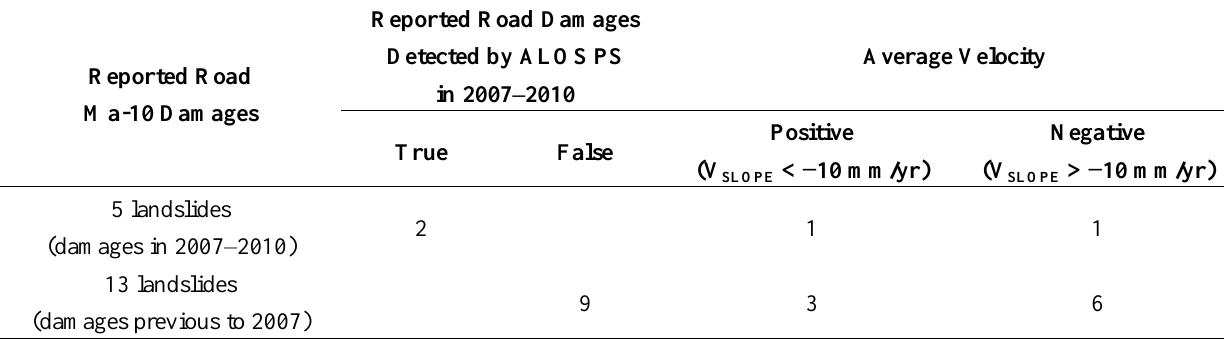
Table 4. Amounts and velocity rates of PS ALOS populations.